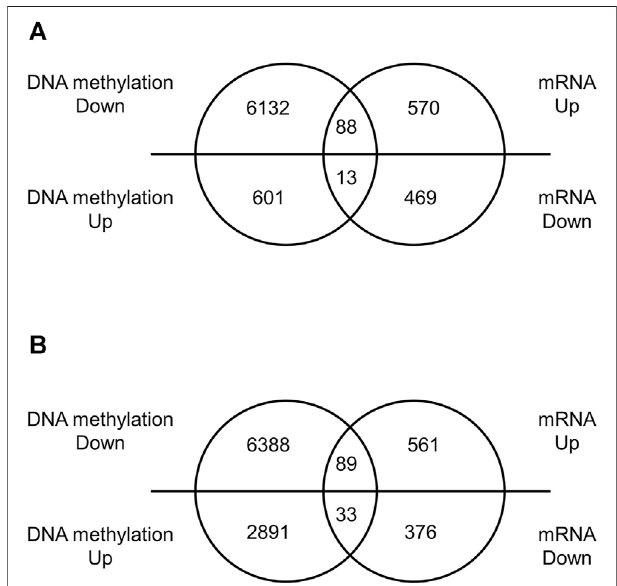
FIGURE 3 | The number of differentially expressed genes with altered DNA methylation following TiO 2 -NP exposure. — Venn diagram analysis whether differentially expressed genes are accompanied by alteration of DNA methylation. Venn diagram showing the number of differentially expressed genes with altered DNA methylation following TiO 2 -NP (Sham vs. TiO 2 -H) in the brains of 1-day-old offspring mice [ (A) : male, (B) : female]. The DNAmethylationstateandexpressionlevelofgeneswereidenti fi edbyMouse CpG Island Microarray and SurePrint G3 Mouse GE 8 × 60 K Microarray, respectively.